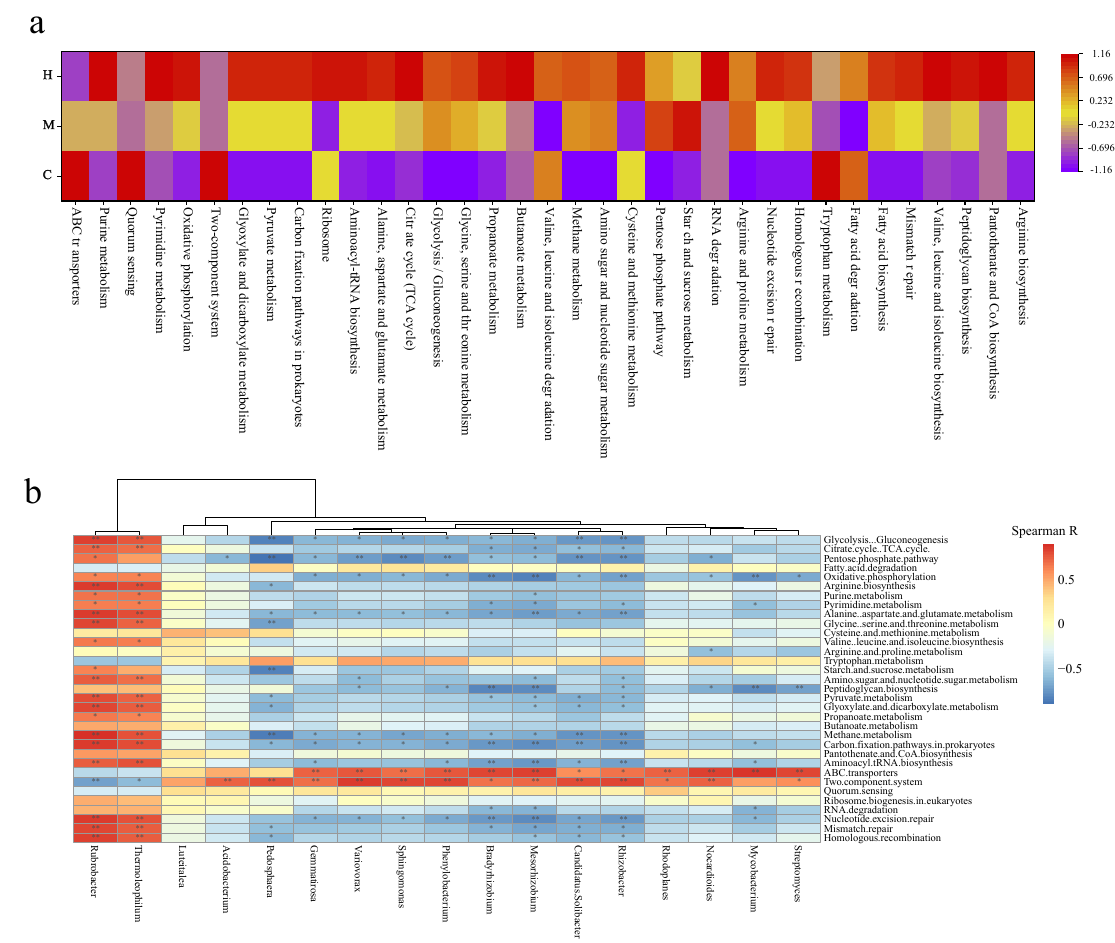
Figure 5. ( a ) Heat map analysis of the top 35 most abundant Kyoto Encyclopedia of Genes and Genomes (KEGG) pathways in at least one soil sample using normalized abundance. Heat map is color-coded based on row z-scores. ( b ) Spearman correlation analysis between genus with significant difference between C and H and metabolic pathway on level 3. “*” represents q value < 0.05; “**” represents q value <